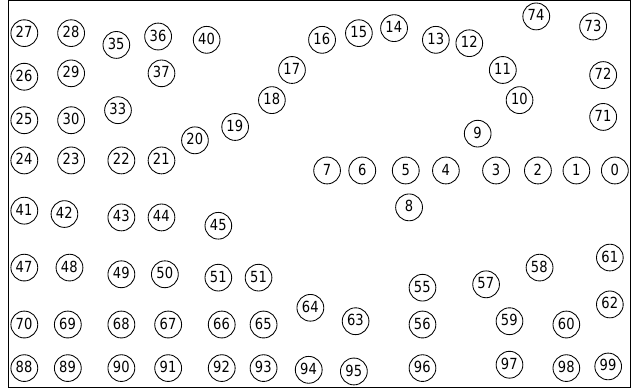
Figure 15. 100 node topology with one communication void.